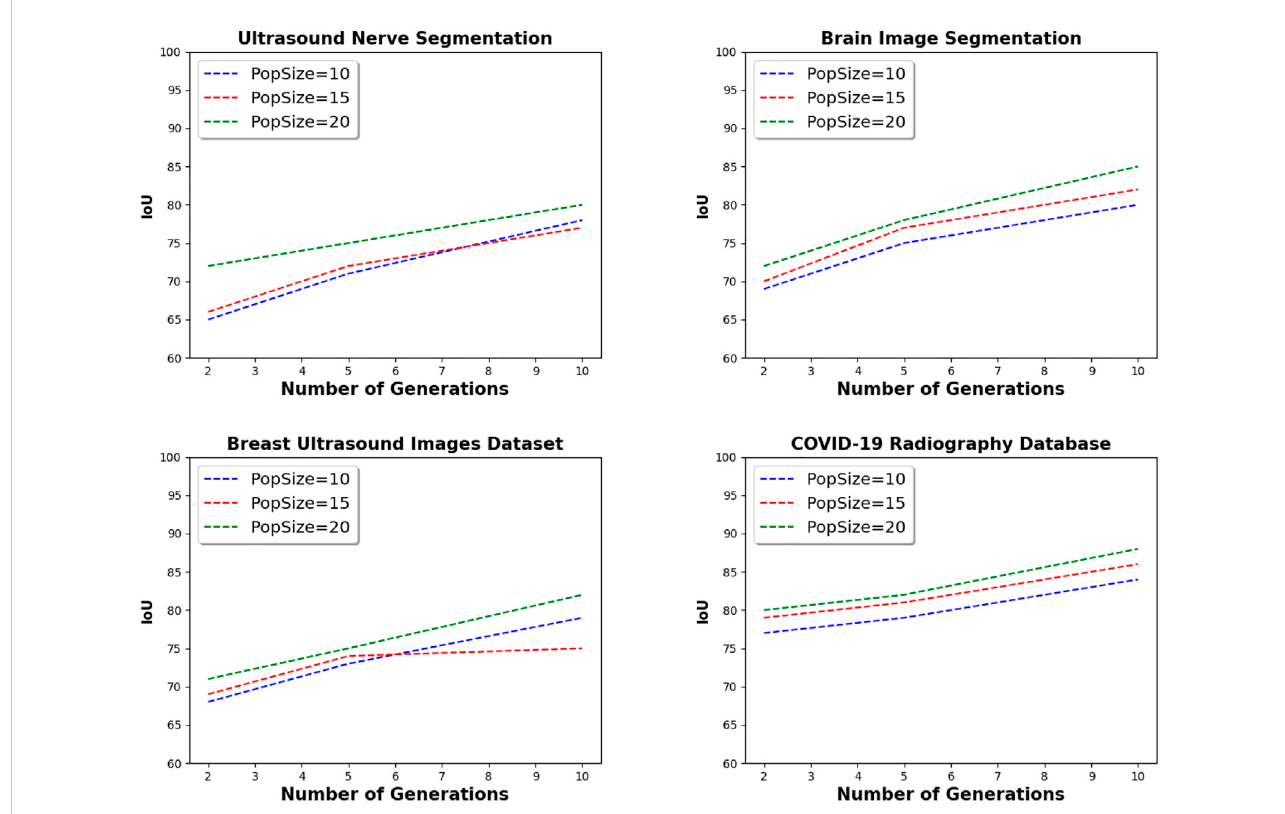
FIGURE 6 Parameter settings of the proposed framework using medical image